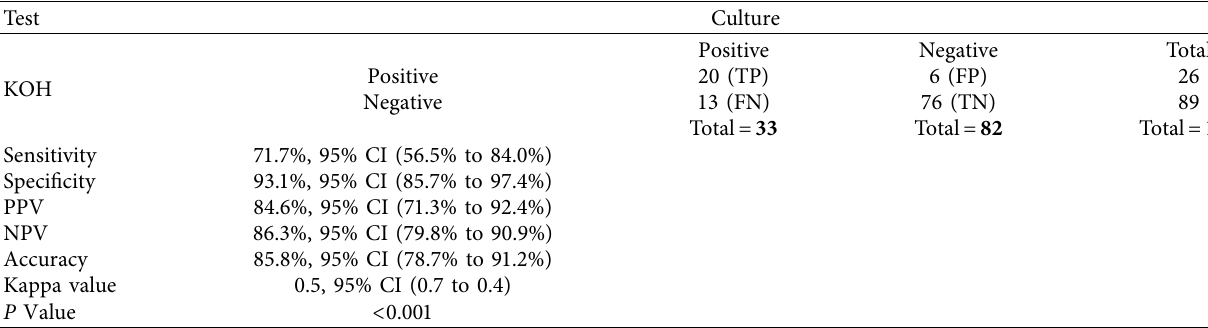
Table 3: Direct microscopic examinations results of nondermatophytes mold with colony characteristics in SDA with their LPCB identification. Number of fungal KOH wet-mount results/Direct microscopic Fungal colony morphological characteristics in LPCB elements observed in examination SDA identification direct KOH wet-mount. Olivaceous-brown to blackish-brown colonies suede-like to floccose turning later into Cladosporium Dark, branched septate fungal hyphae seen. 6 powdery colony due to the production of species abundant conidia. Olivaceous-black pigments in the reverse side. Green, velvety, wrinkled colony. Penicillium Hyaline, branched septate fungal hyphae 2 Not any pigmentation observed in the reverse species seen. side. Granular, flat colonies with radial grooves, Hyaline, branched septate fungal hyphae yellow at beginning later quickly becoming Aspergillus 2 with acute angle branching seen. bright to dark yellow-green. flavus Lemon yellow pigment in reverse side Pale, bright-colored, fast-growing colonies Hyaline, branched septate fungal hyphae Fusarium 2 with a cottony aerial mycelium. No with acute angle branching seen. species pigmentation was observed in reverse side. Woolly to velvety colony, suede like and Phialophora Brown branched septate fungal hyphae seen. 1 olivaceous to black in obverse and reverse side. species Dark brown pigmented, branched septate Dark brown and velvety, loose cottony at the Curvularia 1 fungal hyphae seen. center with black pigmentation in reverse side. species Colonies appeared black to olivaceous-black or Dark, branched septate fungal hyphae seen Alternaria 1 grayish and has suede-like to floccose with branched chains of large conidia. species appearance. Hyaline, branched aseptate fungal hyphae White to grayish brown, fast-growing colonies 1 Mucor species seen. resembling salt and pepper appearance. Plenty of budding yeast cells seen. Soft, smooth, mucoid, and orange pigmented Rhodotorula (Arthroconidia was observed in LPCB colony in the obverse side. species 3 mount and Gram staining prepared from White, small, creamy, and pasty colony Candida species culture) Table 4: Evaluation of KOH preparation with culture for the detection of fungal infection. Test Culture Positive Negative Total 20 (TP) KOH